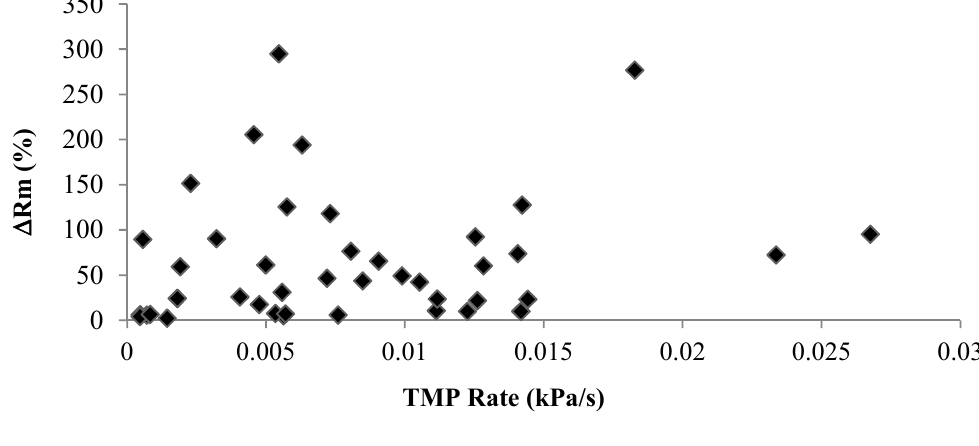
Figure 10. Relationship between irreversible resistances and TMP rate (kPa/s).